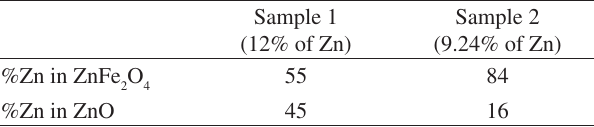
Table 8. Relatio� �etwee� Z� co�te�t i� the Z�Fe EAFD with di��ere�t Z�